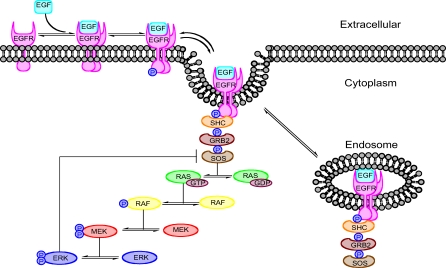
Schematic of EGF-Induced SignalingThis schematic shows the major steps in EGFR signaling. At the top of the pathway ligand binds to the receptor and induces receptor dimerization and activation. The signal is then transduced through a series of adaptor proteins SHC, GRB2, and SOS, which in turn activates the MAPK cascade RAF, MEK and ERK. There are two negative feedback loops: internalization and degradation of the receptor complex, and ERK deactivation of SOS.